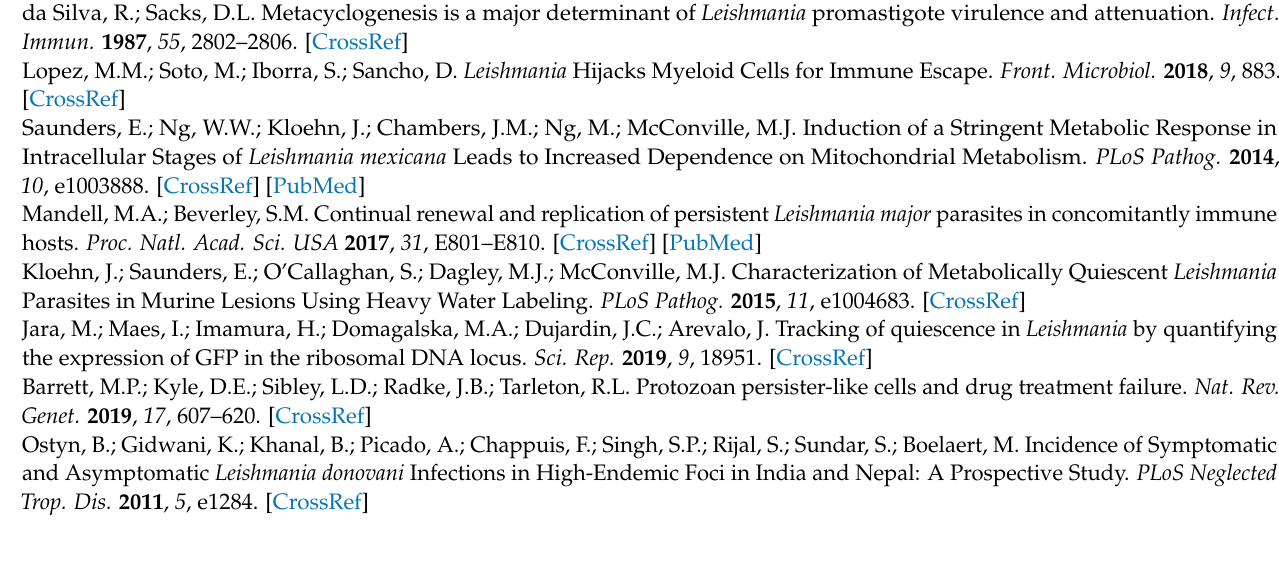
Figure S3: Normalization of samples with the use of ERCC Spikes-In, Figure S4: Overview of the 135 genes with modulated TPM in all quiescent conditions, Figure S5: Transcripts commonly modu- lated across quiescent condition are located in many genomic locations and their TPMs distribution differs of the overall transcriptome, Figure S6: Quiescent cells have changes in the composition of their metabolome when compared to proliferating cells, Table S1: Transcriptome ERCC Spikes- In normalized, Table S2; Transcriptome TPM normalized, Table S3: Metabolomics with Cell and IPT